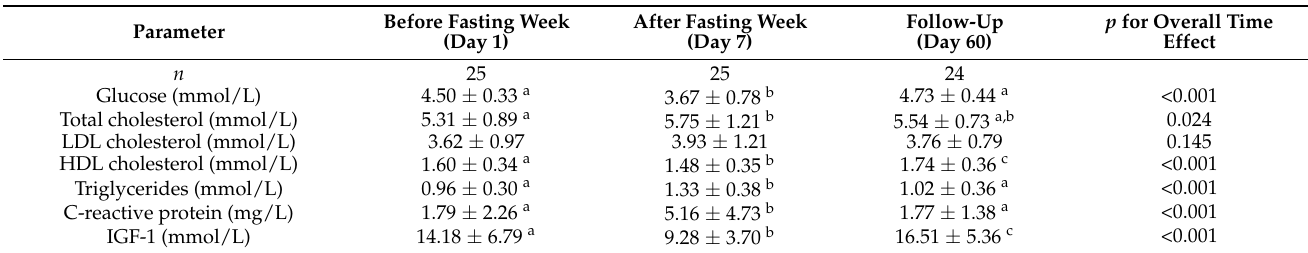
Table 1. Circulating levels of glucose, cholesterol and triglycerides, C-reactive protein and IGF-1 assessed just before the fasting week started (Day 1), at fasting week completion (Day 7) and at a 2-month follow-up (Day 60) in n = 25 generally healthy adults with at least one clinical criterion for metabolic